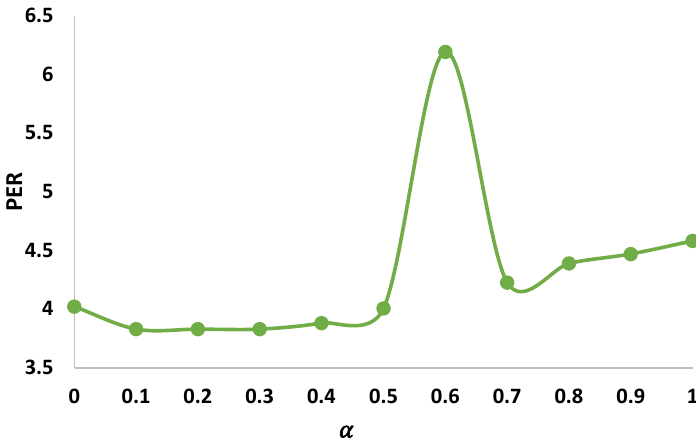
Figure 4. Selection of the parameter ( α ) of the weighted average.